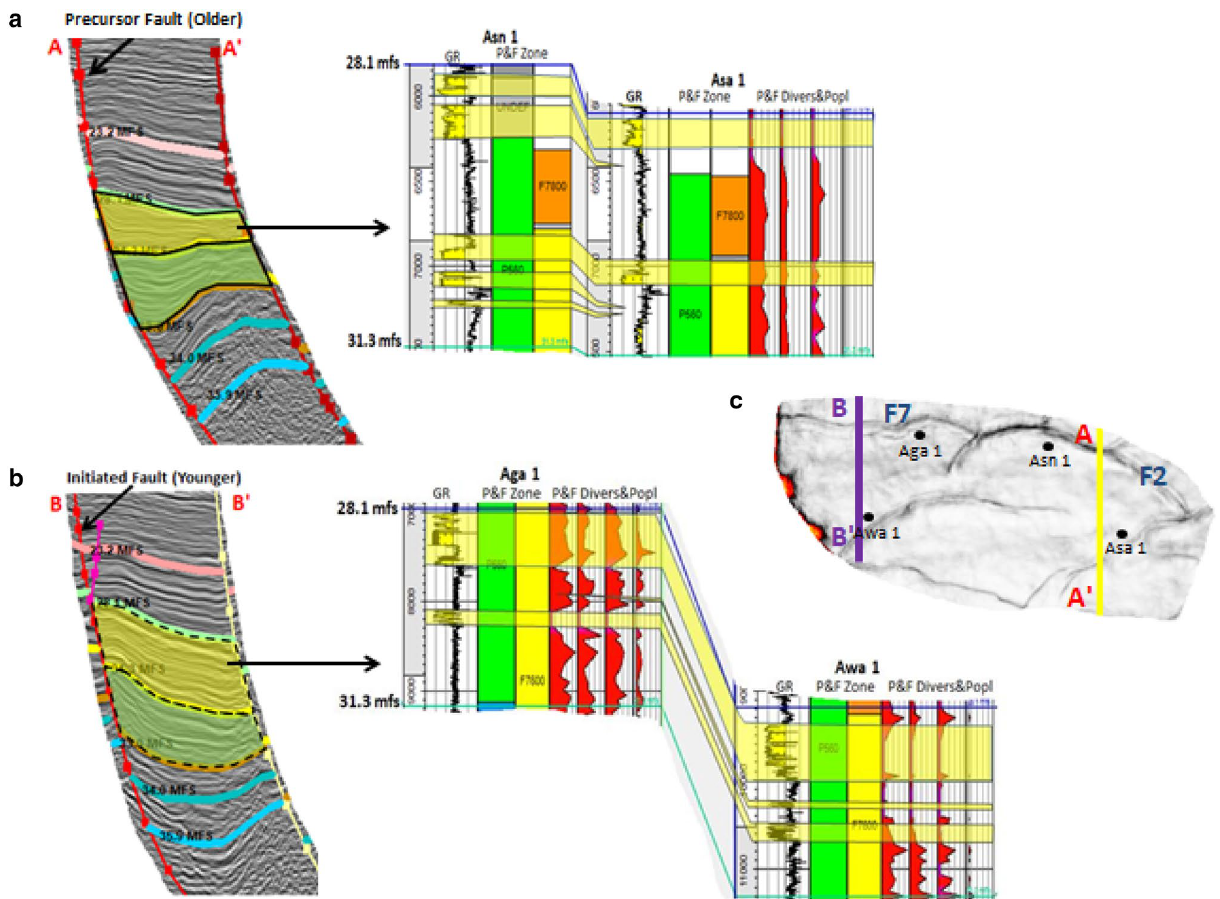
Fig. 20 Seismic traverses and well logs correlation across a precursor fault 2 adjacent seismic reflection geometry and reservoir distribu- tion, b initiated younger fault 7 adjacent seismic reflection geometry